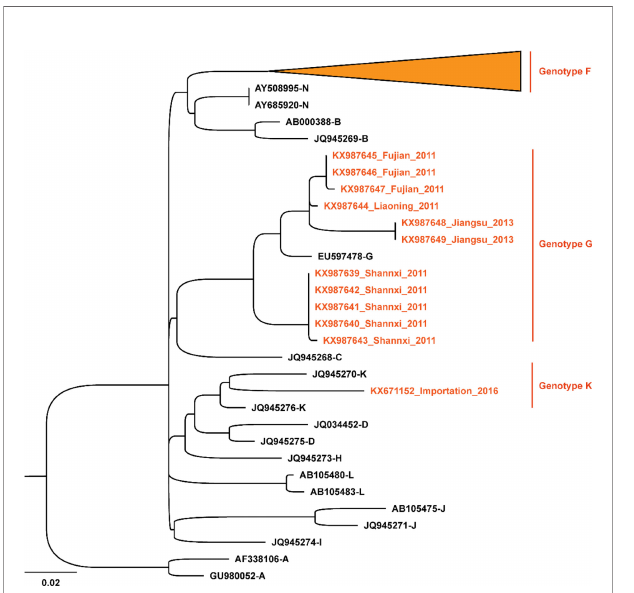
FIGURE 5 | The Maximum Clade Credibility tree of genotype F strains circulated in China with geographic information based on 313 nucleotides of the SH